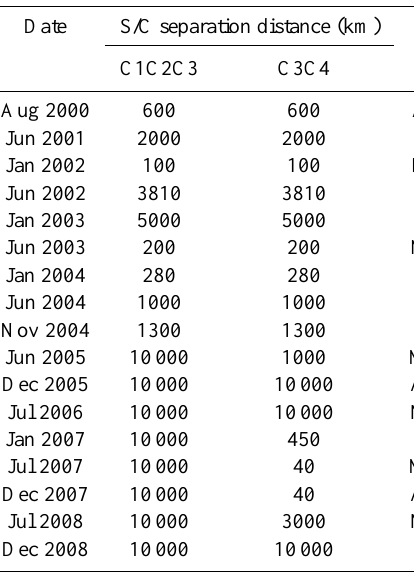
Table 2. Cluster constellation changes from the beginning of the mission in 2000 to end 2013.